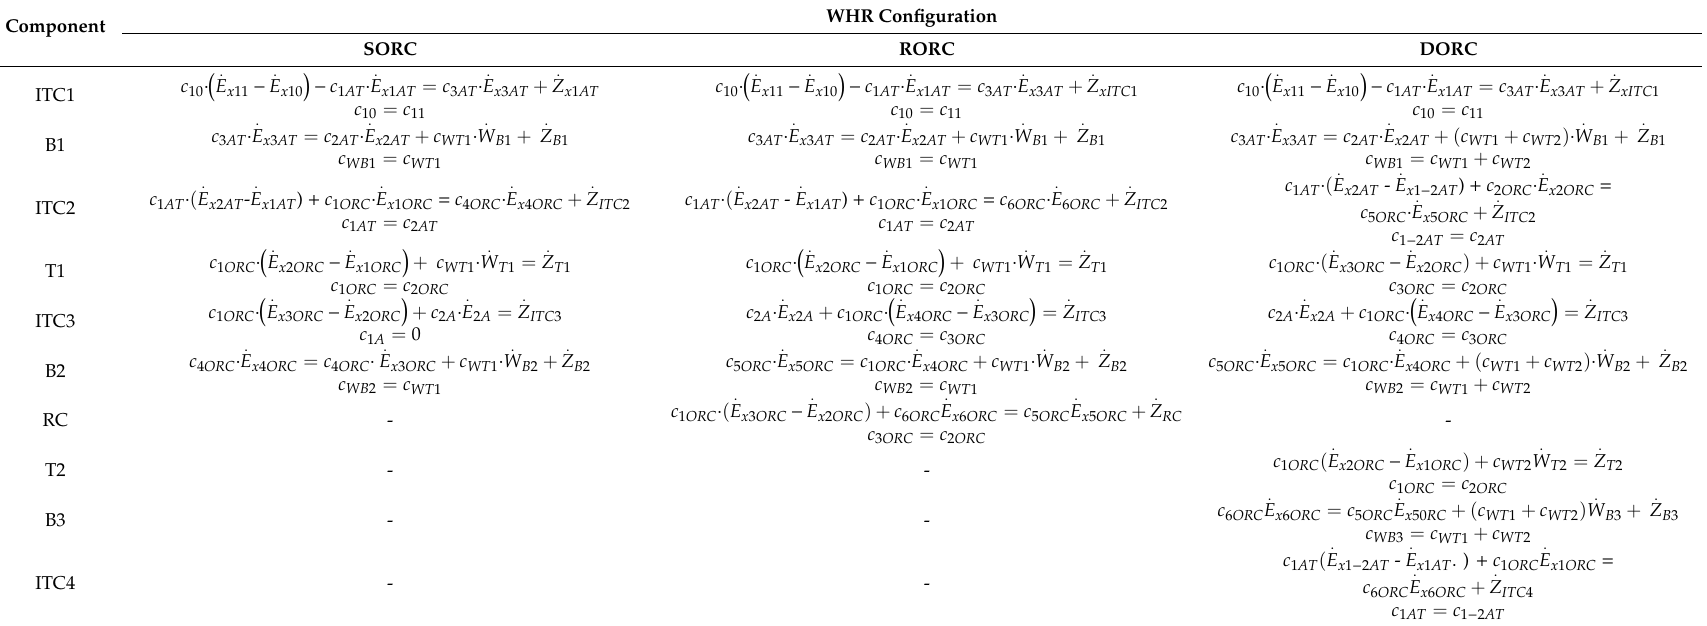
Table A1. Exergetic cost balances of the components in the WHR system using